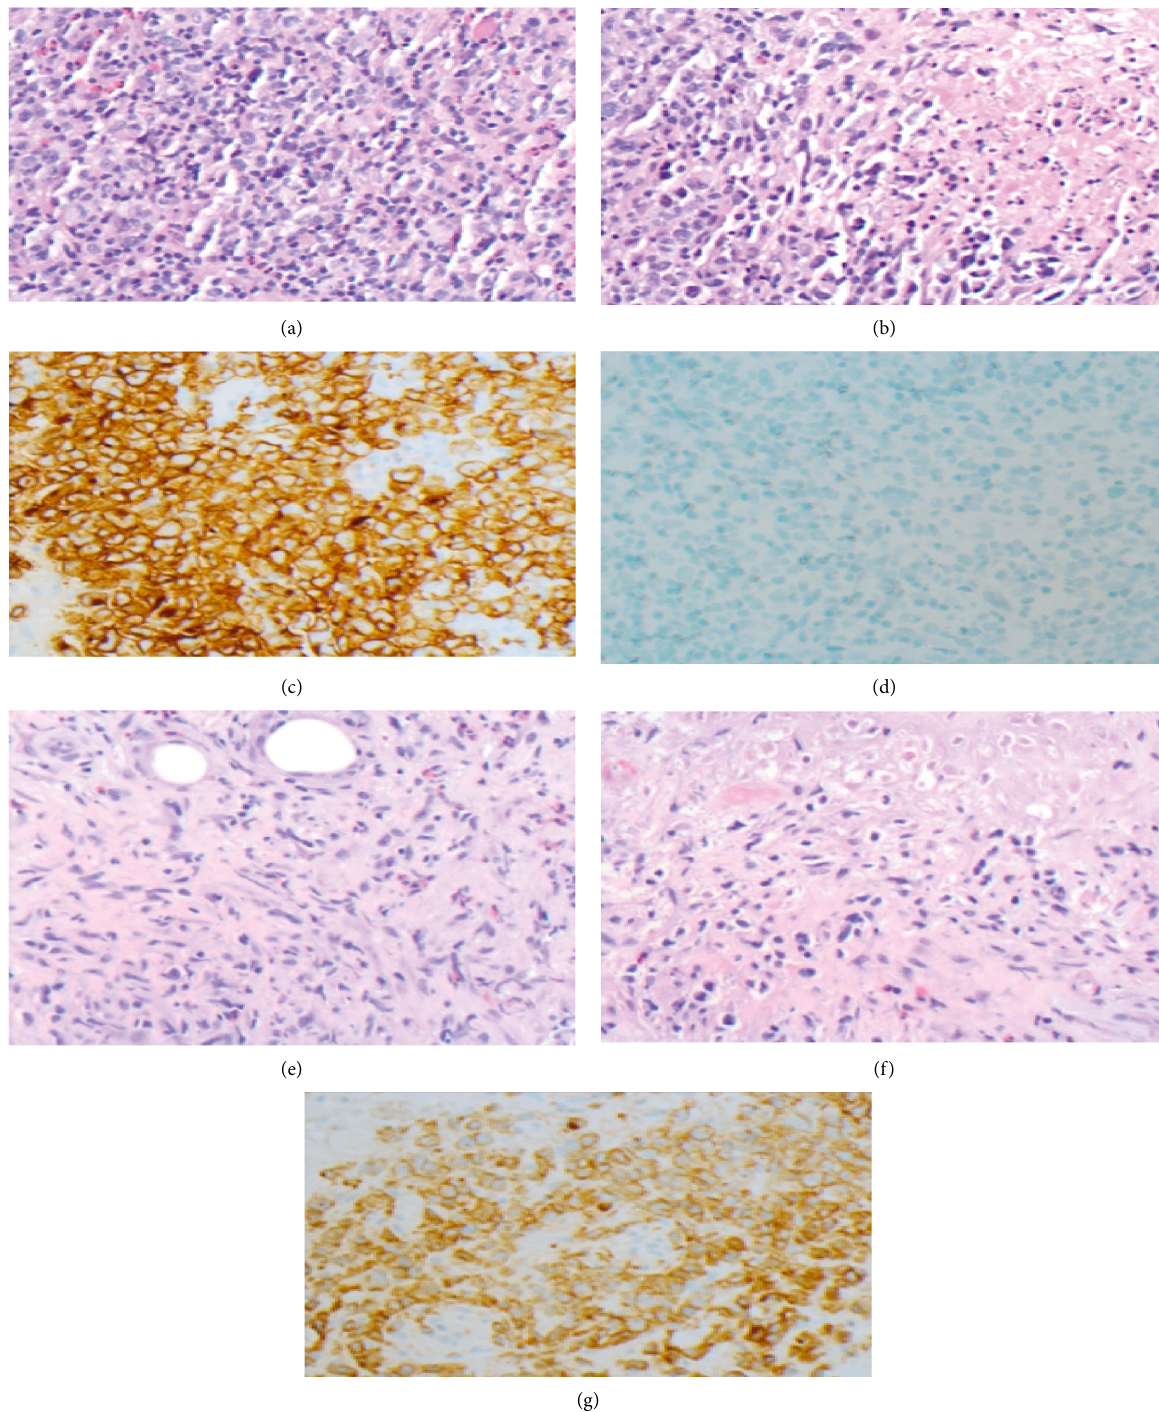
Figure 1: Right axillary lymph node biopsy. (a) Proliferation of large, atypical cells with irregular nuclear contours, vesicular chromatin, and moderately abundant eosinophilic cytoplasm, with background small lymphocytes and eosinophils. (b) Proliferation of large, atypical cells alternating with areas of necrosis. (c) Lymphoma cells stain positive for CD30. (d) Lymphoma cells stain negative for ALK. Right chest wall mass biopsy with (e) large lymphoma cells within background fibrosis, small lymphocytes, and eosinophils (f) with associated adjacent necrosis (g) with lymphoma cells staining positive for